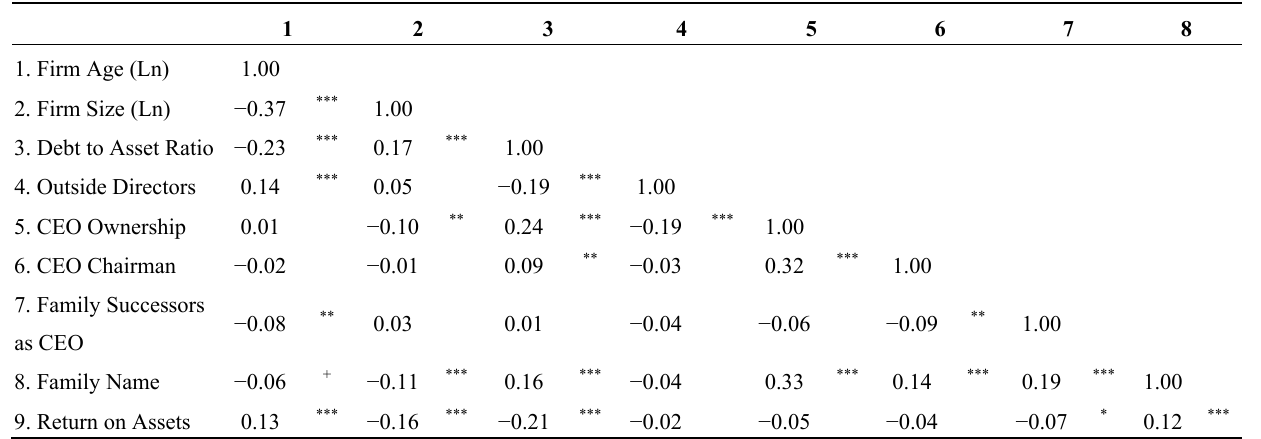
Table 4. Correlations Matrix.